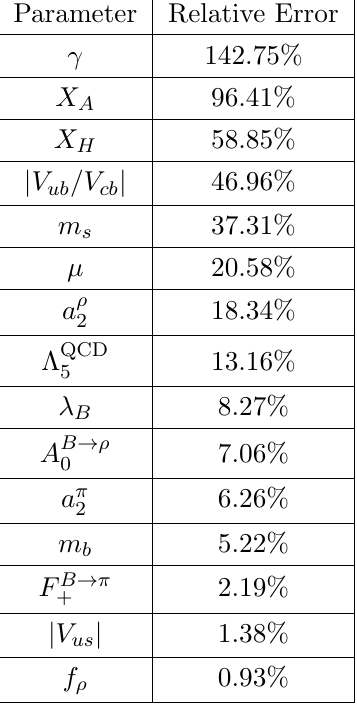
Table 4 . Error budget for the observable S (cid:25)(cid:26) (Part I). Here A B ! (cid:26)